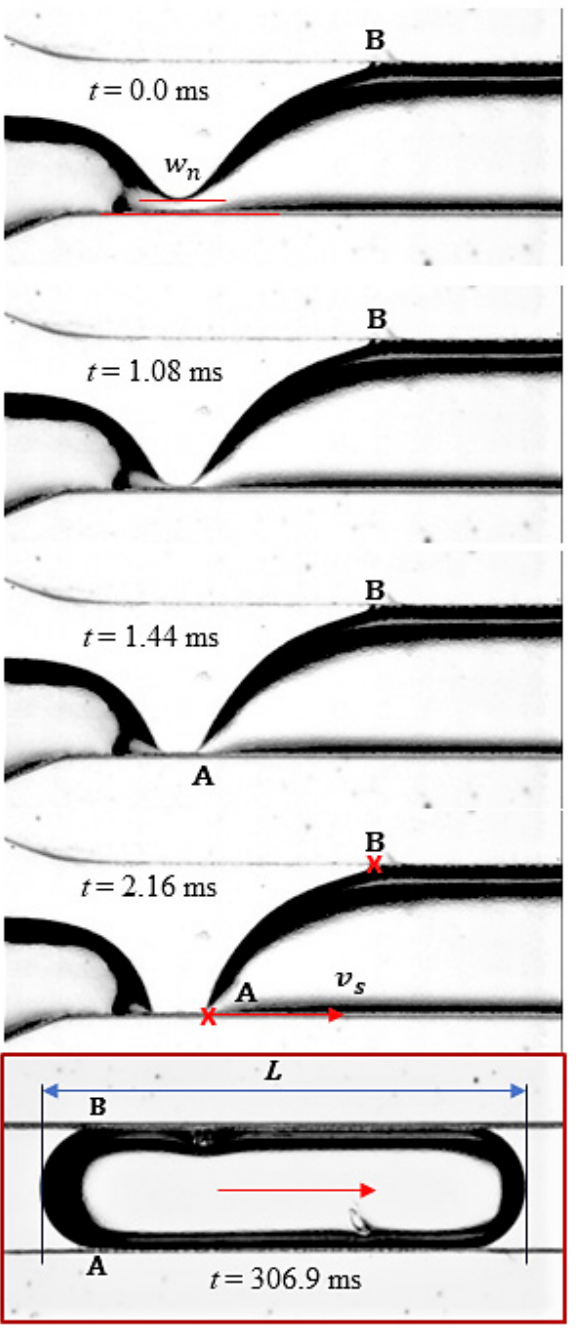
Figure 7. Onset of the dripping mode in the microchannel with elongated droplets ( L/a > 1); time evolution of the breakup phenomena and the formation of the water droplet; images extracted from video recordings (see Video S1 in the Supplementary Materials, at the moments marked in the pictures). Here, the space points A and B are limiting the droplet after the rupture of the interface. The length L was measured by image processing of selected pictures using a procedure implemented in ImageJ software. Red arrows indicate point A and droplet velocity direction. Final droplet is marked in the red square.